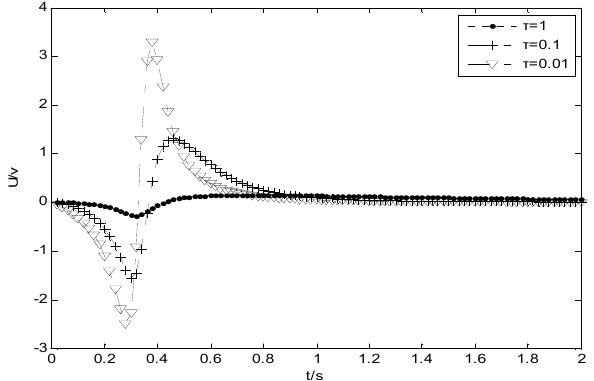
Figure 15. System time responses with gravitational